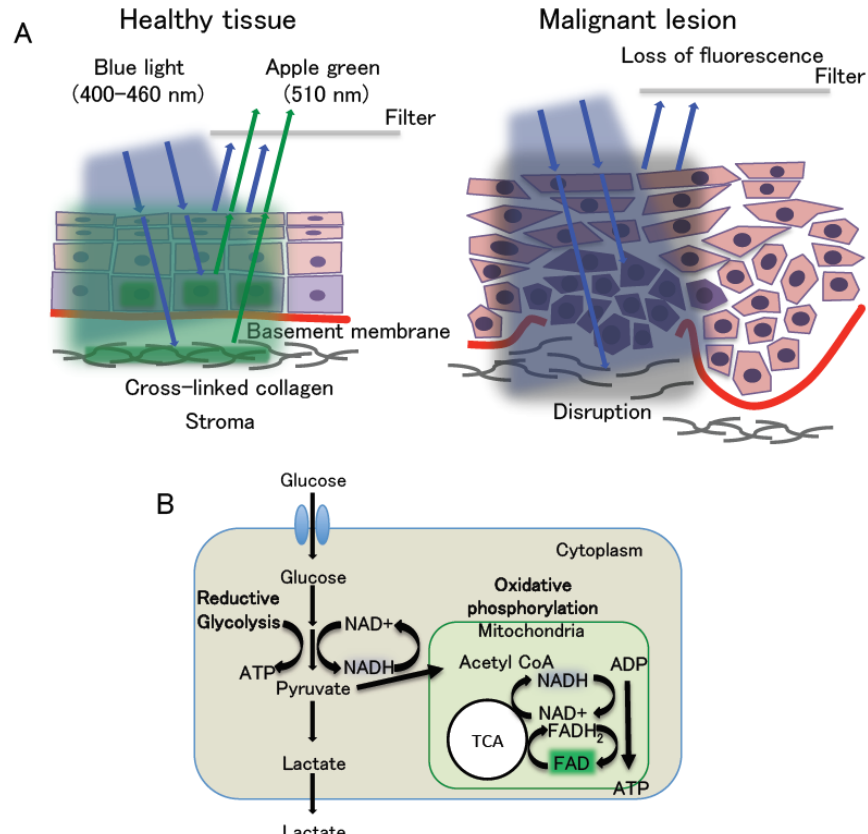
Figure 2. The mechanism underlying autofluorescence-based diagnosis. ( A ) Under blue light at 400–460 nm, healthy tissues exhibit apple green fluorescence (510 nm), while malignant lesions display a loss of autofluorescence. This is related to the redox ratio, autofluorescence of cross-link collagen, and the filtering effect. ( B ) Cell metabolism. This phenomenon is related to the Warburg effect. Malignant lesions dominate reductive glycolysis, leading to the decrease in the redox ratio. TCA: tricarboxylic acid cycle.